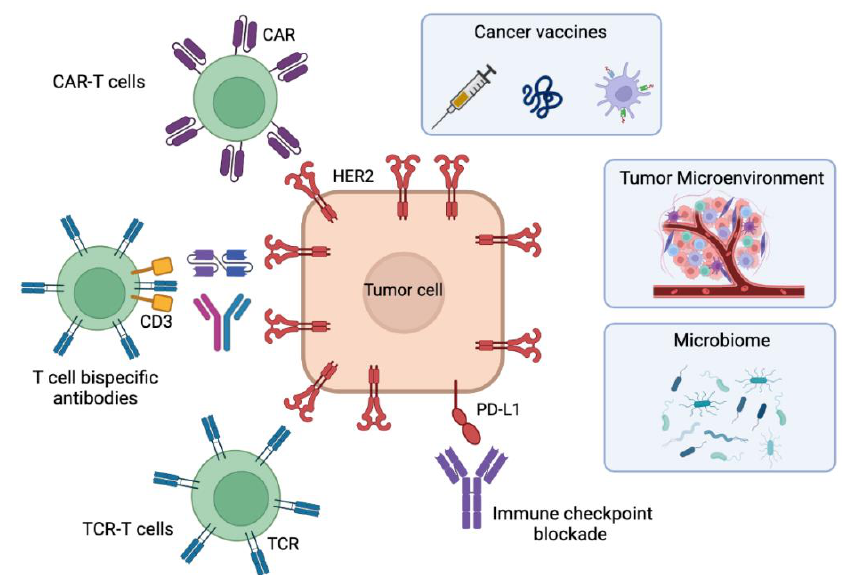
Figure 1. Immunotherapeutic approaches for HER2-positive breast cancer in development to overcome resistances to current therapies. The figure contains cancer vaccines including polypeptide/protein-based or cell-based vaccines, the antibody-based immune checkpoint blockade, the adoptive cell therapies using TCR-T cells, T-cell bispecific antibodies or CAR-T cells, and the factors influencing immunotherapeutic responses: the tumor microenvironment and the microbiome. Figure created with Biorender.com.